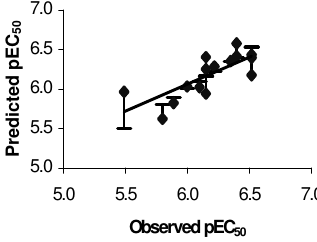
Figure 4. Plot between observed pEC